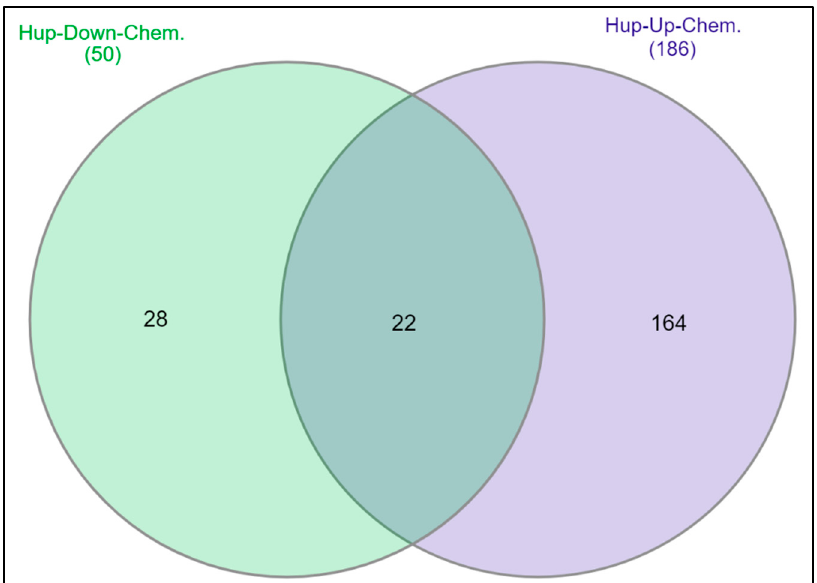
Figure 11. Venn diagram generated from CTD analyses of chemicals associated with 5 up-regulated hub genes (NCAPG, MKI67, TPX2, CCNA2, CCNB1) and 7 down-regulated hub genes (CDK1, CCNB2, AURKA, UBE2C, BUB1B, CENPF, RRM2) associated with PCa. Fifty chemicals are associated with 5 up-regulated and 186 with 7 down-regulated hub genes, and 22 chemicals have been shown to have effects on the expression levels of 12 hub genes. Table 3. The list of chemicals includes heavy metals, PAH, environmental phenols, pesticides, estrogenic compounds, and others. In this list, 17 are recognized EDCs that are associated with the hub genes in CTD studies.